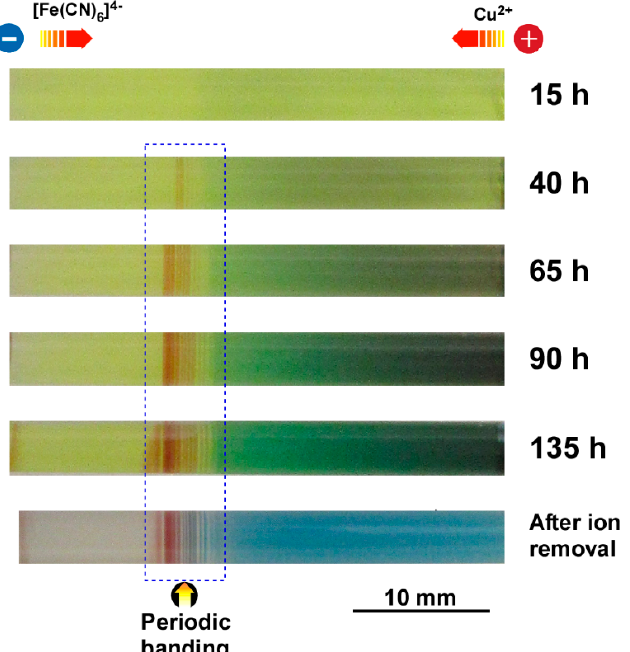
Figure 8. Spatiotemporal evolution of a typical multicolored pattern formed at 25 °C in the sample tube under 20 cycles of 4 V (1 h)–1 V (4 h). The initial conditions are as follows: [[Fe(CN) 6 ] 3 − ] = 0.050 M and 2.0 mass% agarose. The elapsed time after initial voltage application is indicated at the right of each image. Bottom: the pattern after removing unreacted ions. The arrow at the bottom indicates the region where periodic bands were formed. A scale bar is also provided at the bottom of the image. Top: illustration of the charges of the electrodes and the movement directions of reactant ions induced by the electric field.